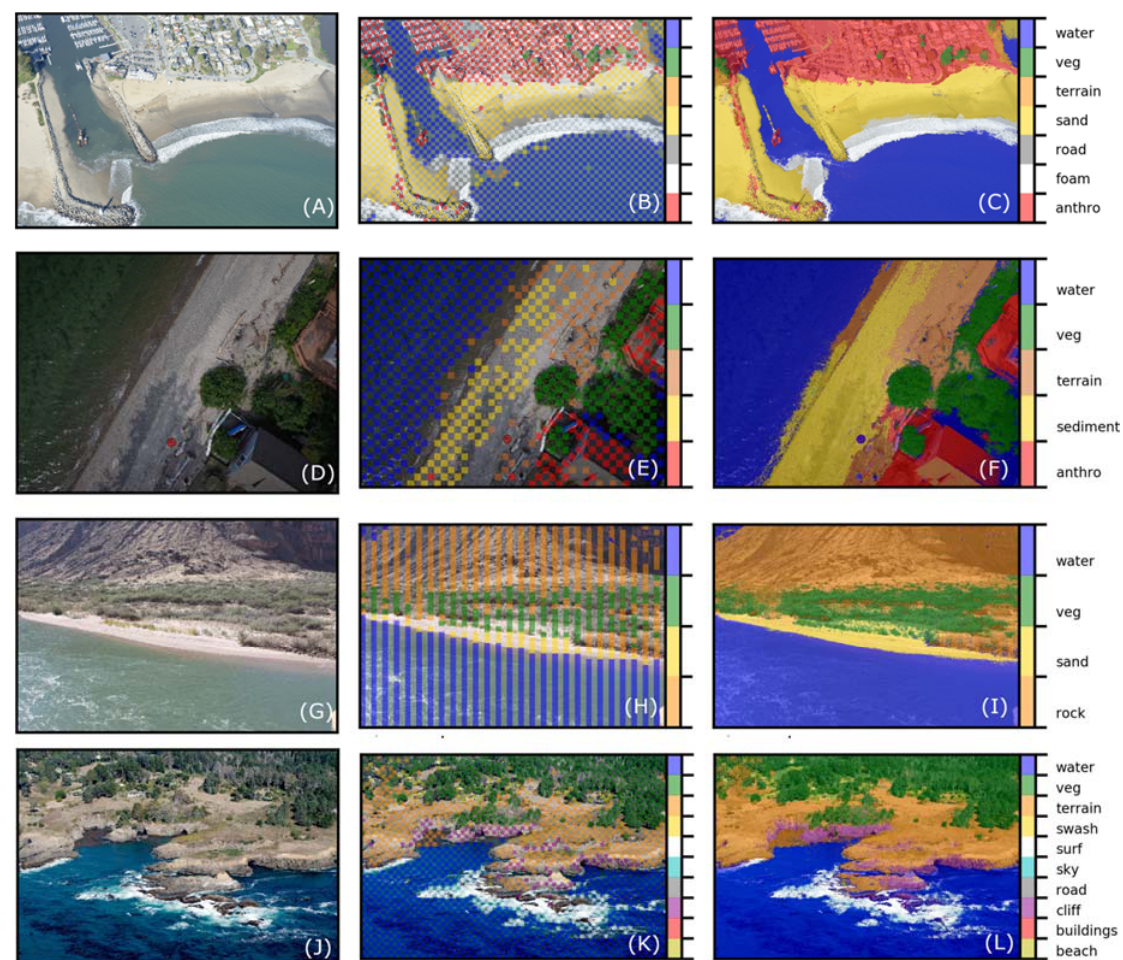
Figure 8. Example images ( A , D , G , J ), DCNN ‐ derived unary potentials ( B , E , H , K ), and CRF ‐ derived pixelwise semantic segmentation ( C , F , I , L ) for each of the four datasets; from top to bottom: Seabright, Lake Ontario, Grand Canyon, and CCRP.